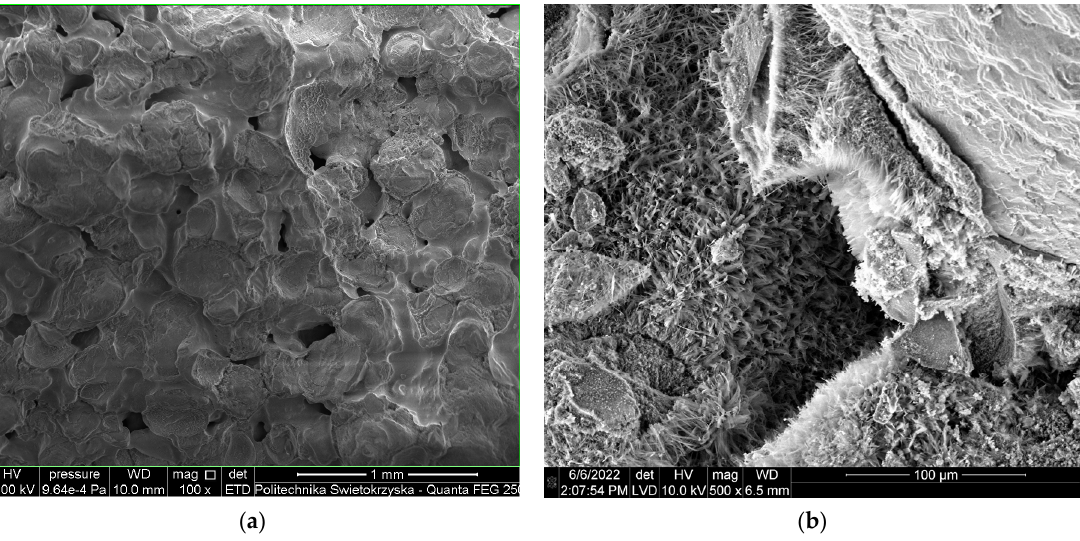
Figure 3. Traditional (reference) silicate brick observed under a scanning electron microscope (SEM); ( a ) microstructure of the material after 36 months from the production of traditional silicate bricks produced in industrial conditions, 1 mm magnification; ( b ) the microstructure of a reference brick produced in industrial conditions after 20 years from the date of production, 100 µ m magnification. C-S-H is a phase which is responsible for the development of strength in concrete.